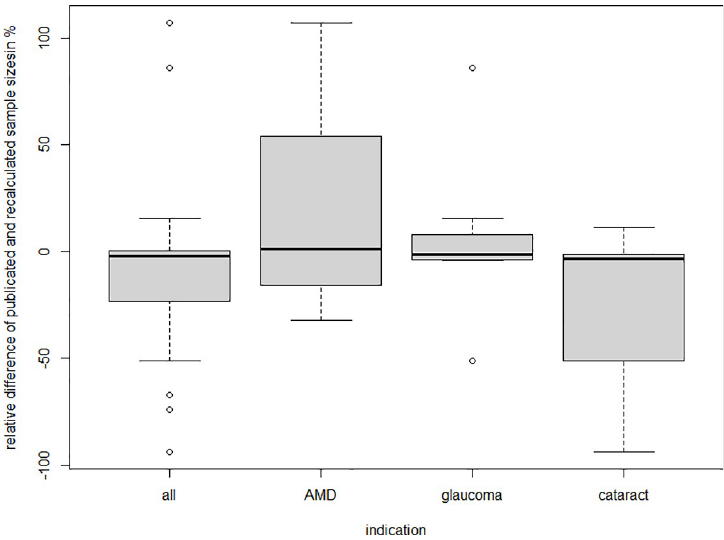
Fig 4. Per cent deviation boxplot. Boxplot on the distribution of per cent deviations between recalculated and published sample size (in total and separately by treatment